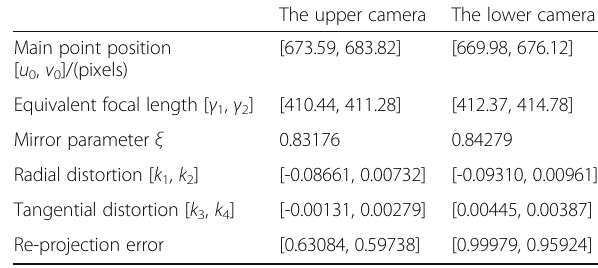
Table 1 Mirror parameters and camera parameters given by the